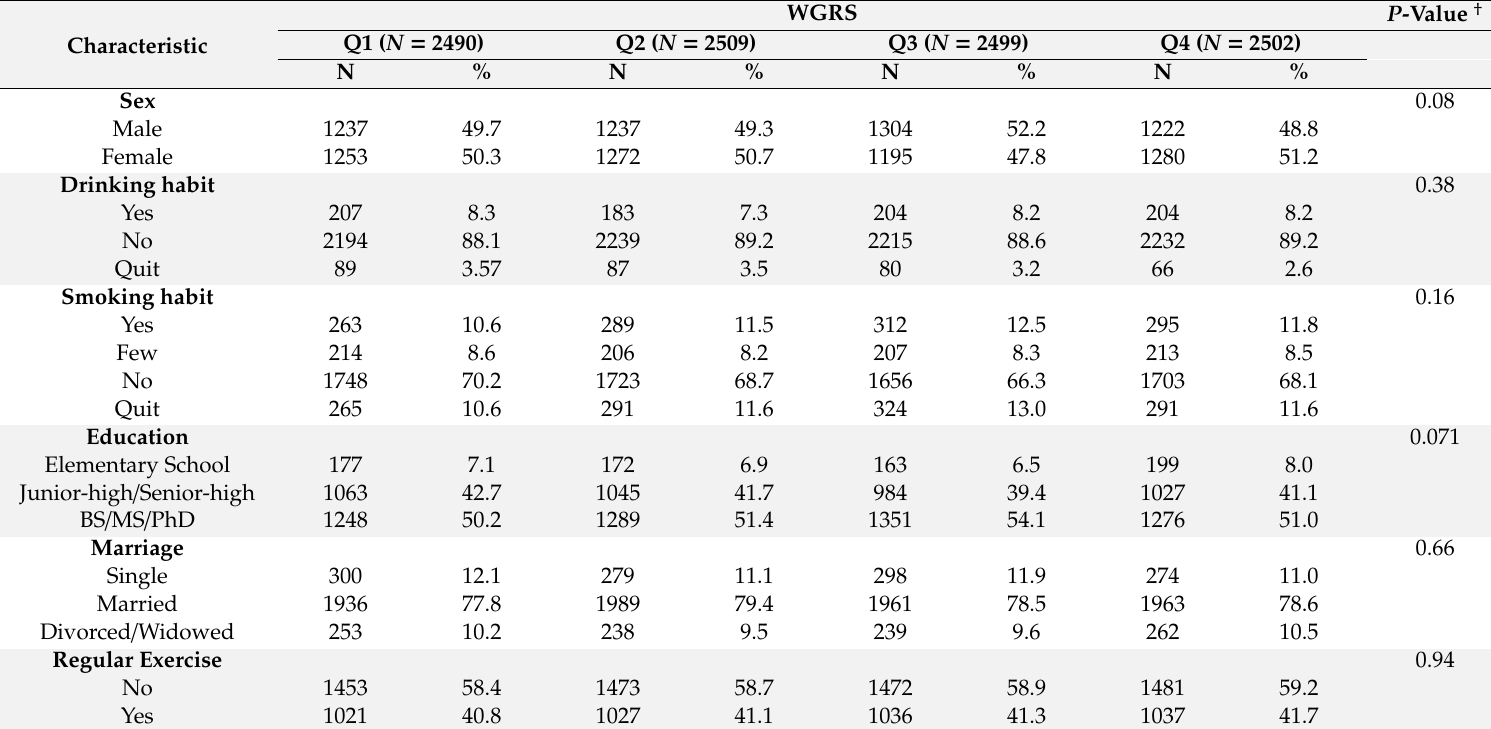
Table 3. Sample characteristics by WGRS quartile (categorical